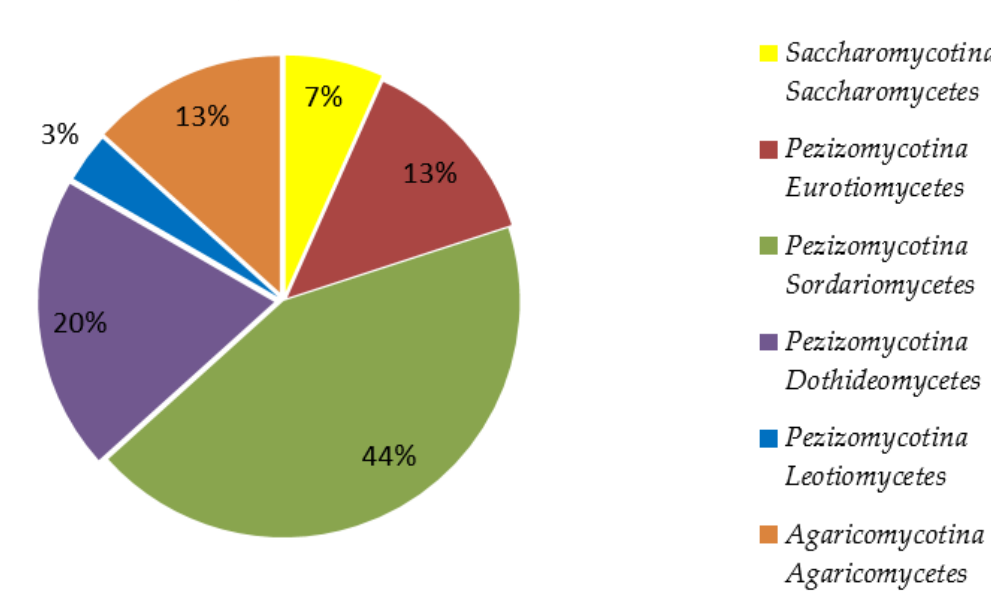
Figure 2. A variety of fungi with the greatest number of produced substances (more than 20).